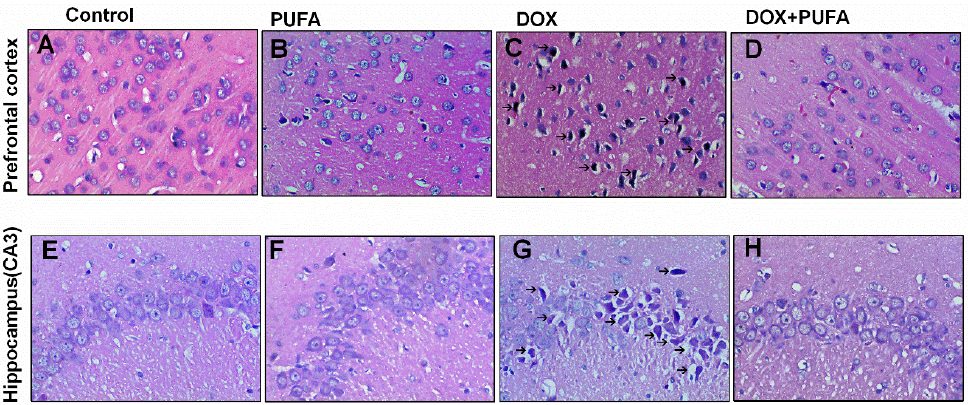
Figure 5. Effects of DOX and ω -3 PUFAs on histological changes in the prefrontal cortex and hippocampus (magnification 400 ˆ ). Note the presence of degenerating neurons (arrows) in the DOX-treated